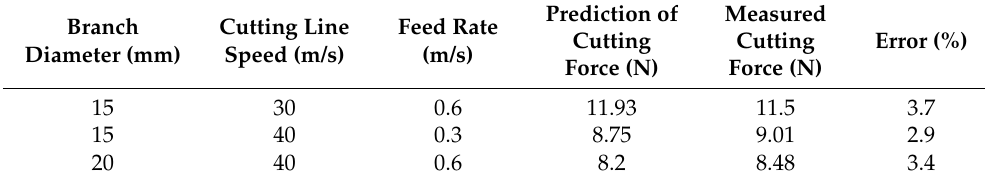
Table 4. Results of verifying